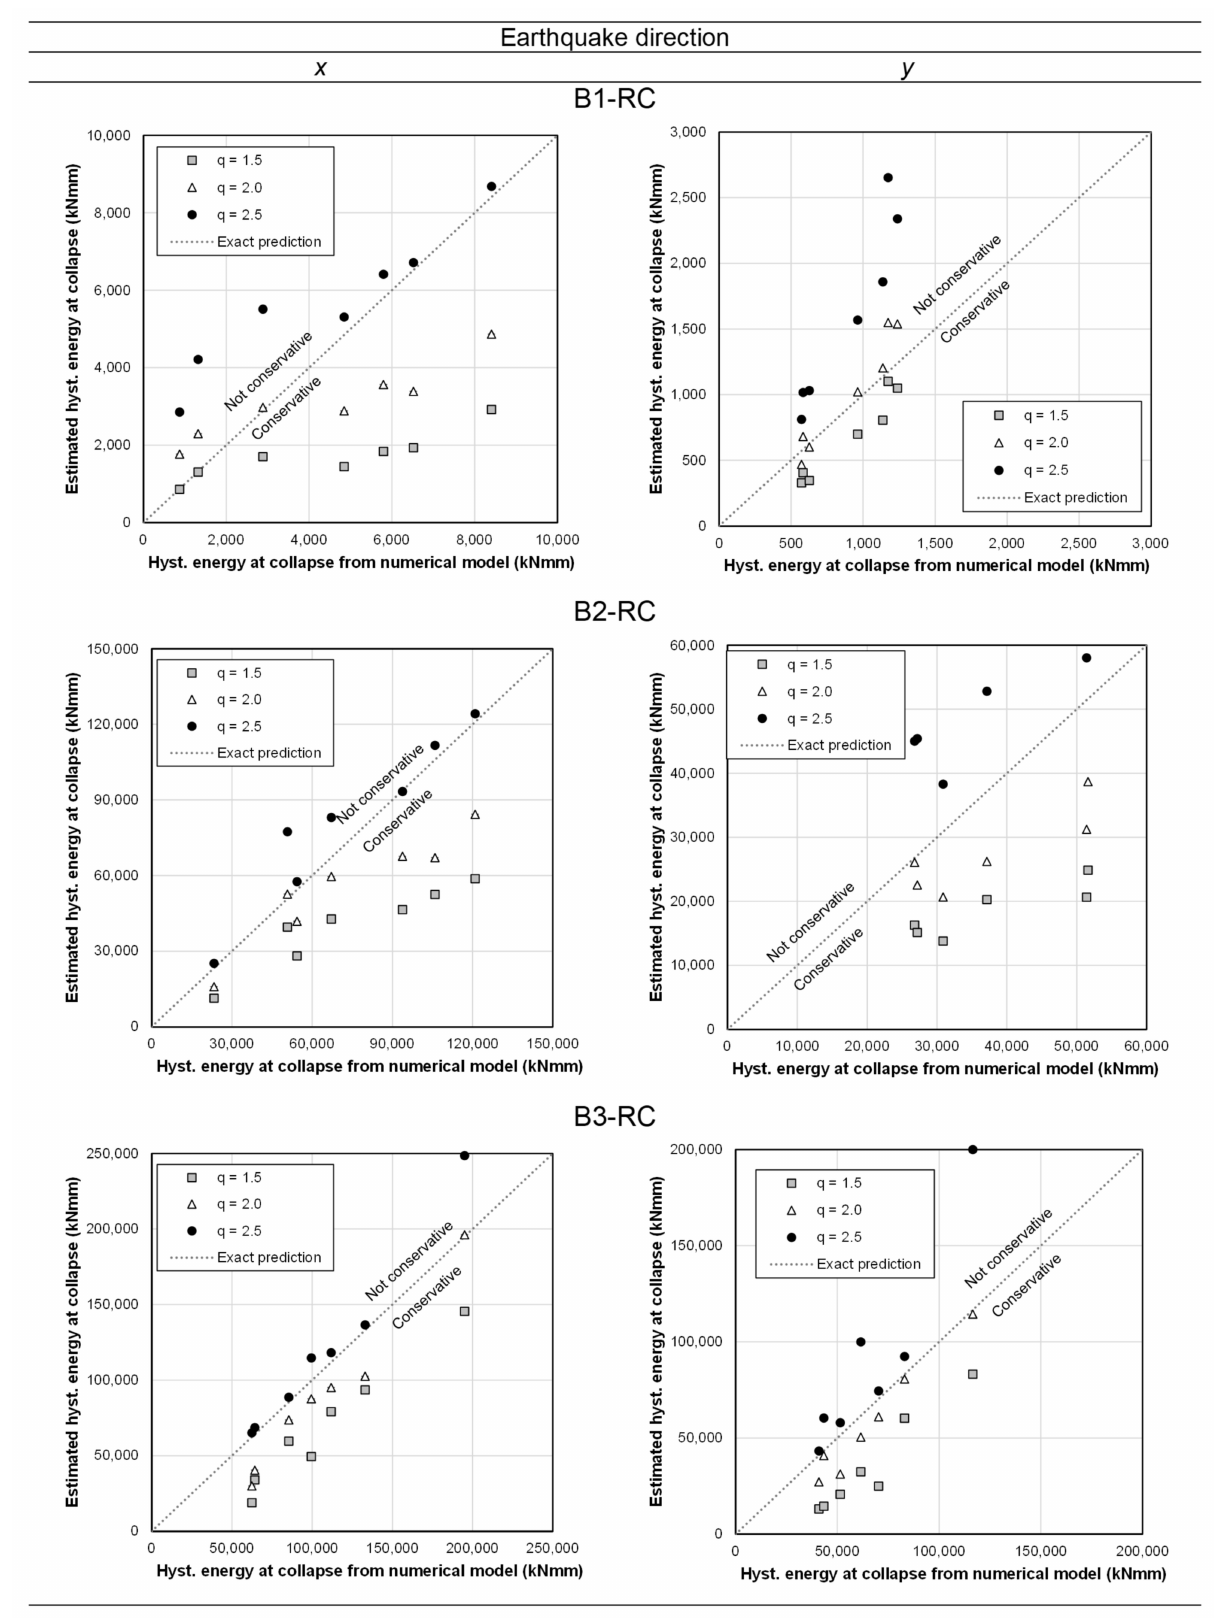
Figure 15. Hysteretic energy from the numerical model and predicted with Equations (1)–(3) for the concrete slab